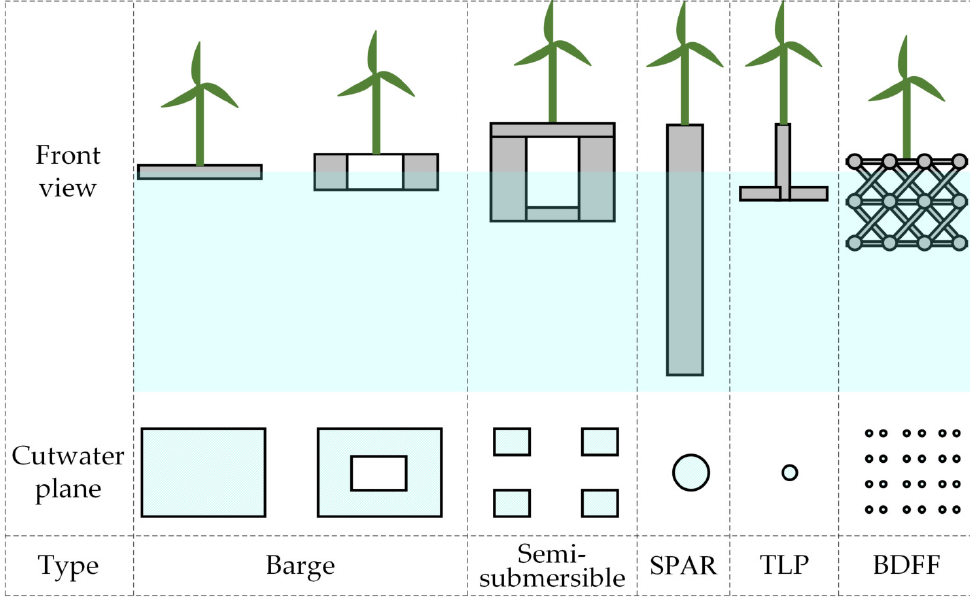
Figure 1. The area of cut-water plane varying with floating types without showing mooring